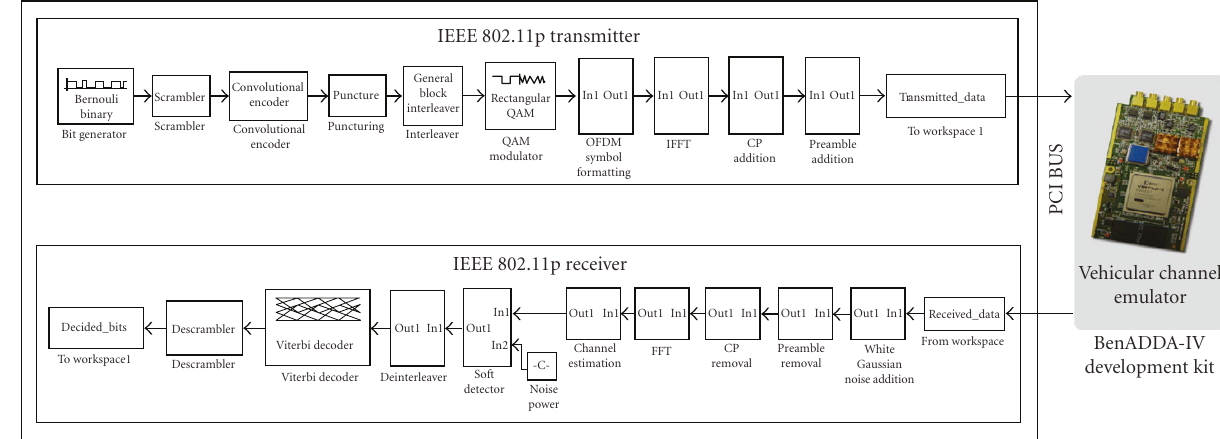
Figure 8: General view of the IEEE 802.11p evaluation system.